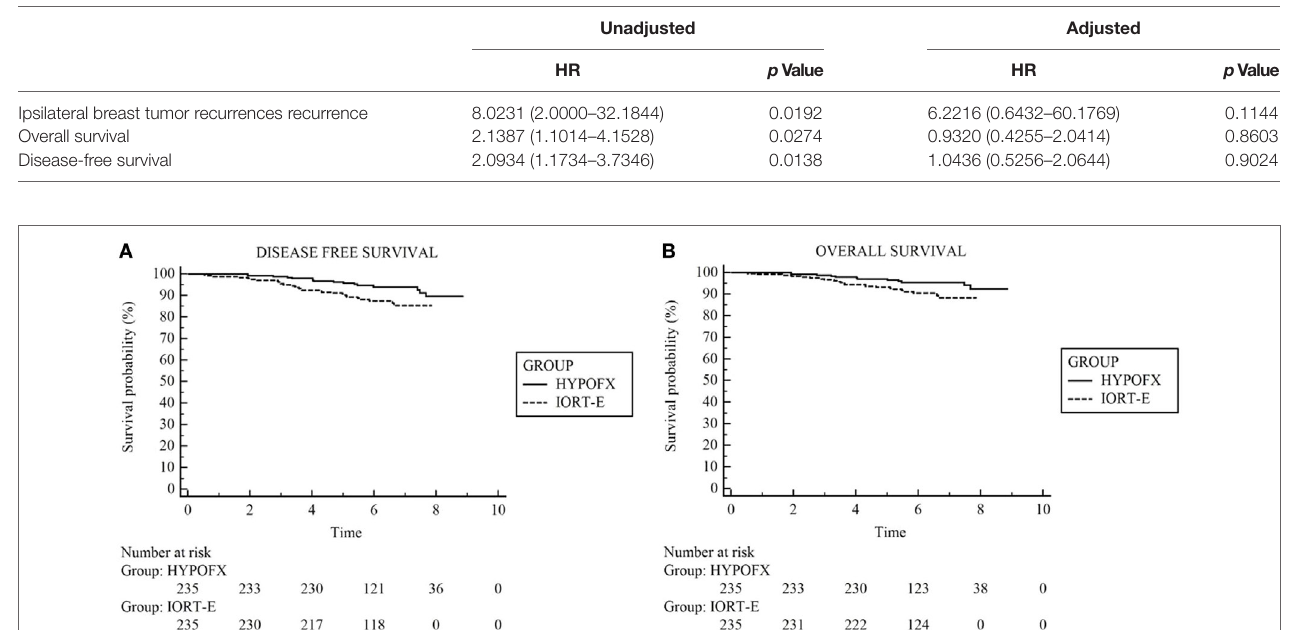
TaBle 4 | Unadjusted and adjusted hazard ratios (HRs) in patients treated with intraoperative radiation therapy with an electron beam (IORT-E) compared with HYPOFX.